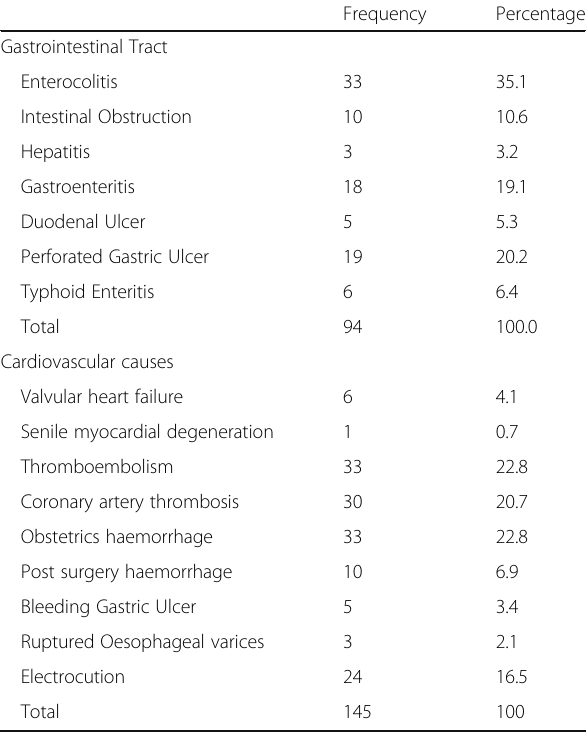
Table 4 Gastrointestinal tract and cardiovascular causes